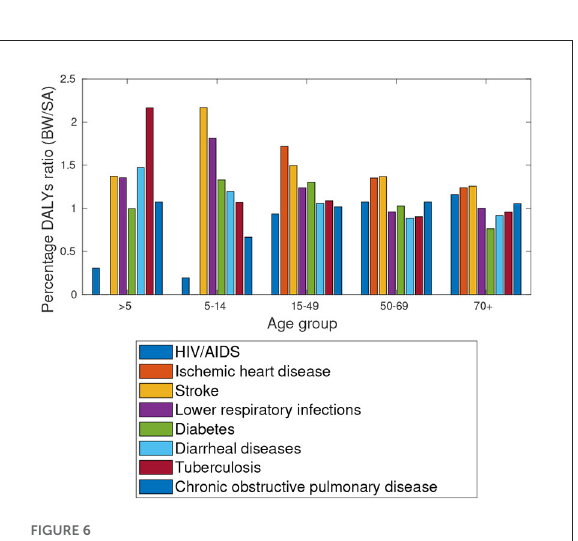
FIGURE5 South Africa: Percentage (%) of total DALYs, Comorbidities in 2019.